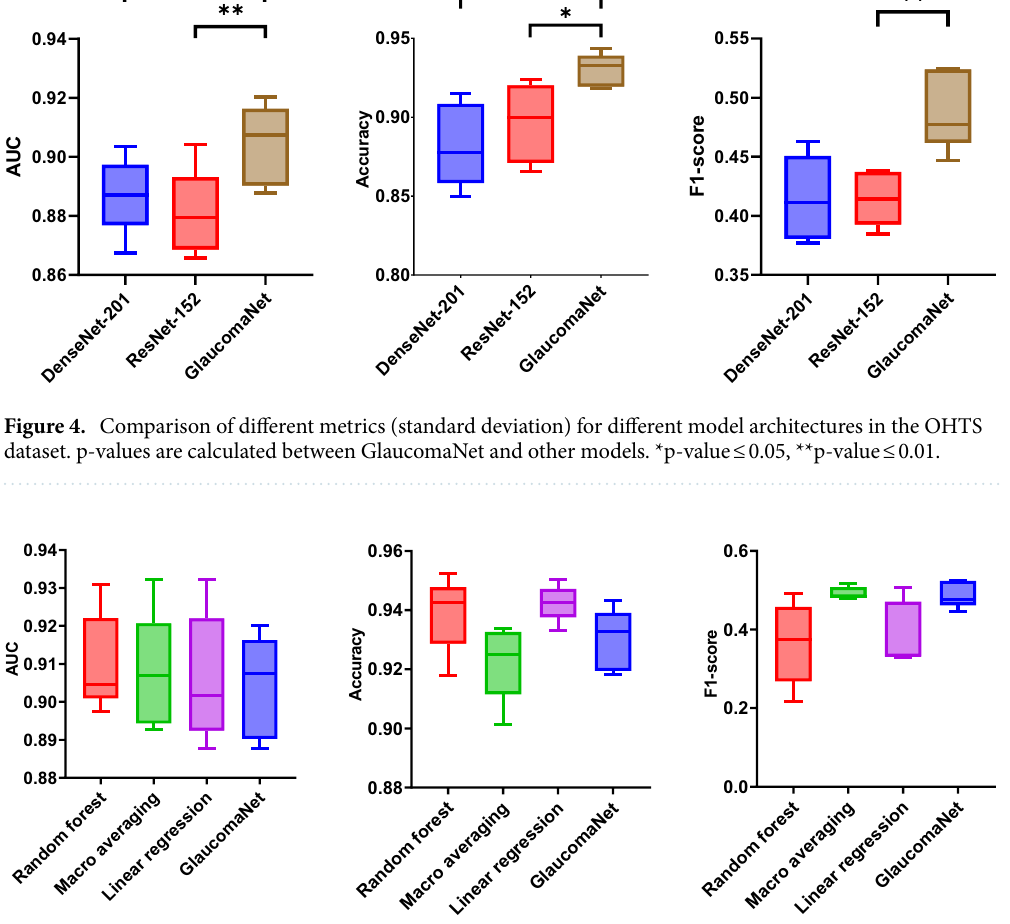
Figure 5. Comparison of different metrics (standard deviation) for proposed and ensemble methods in the OHTS